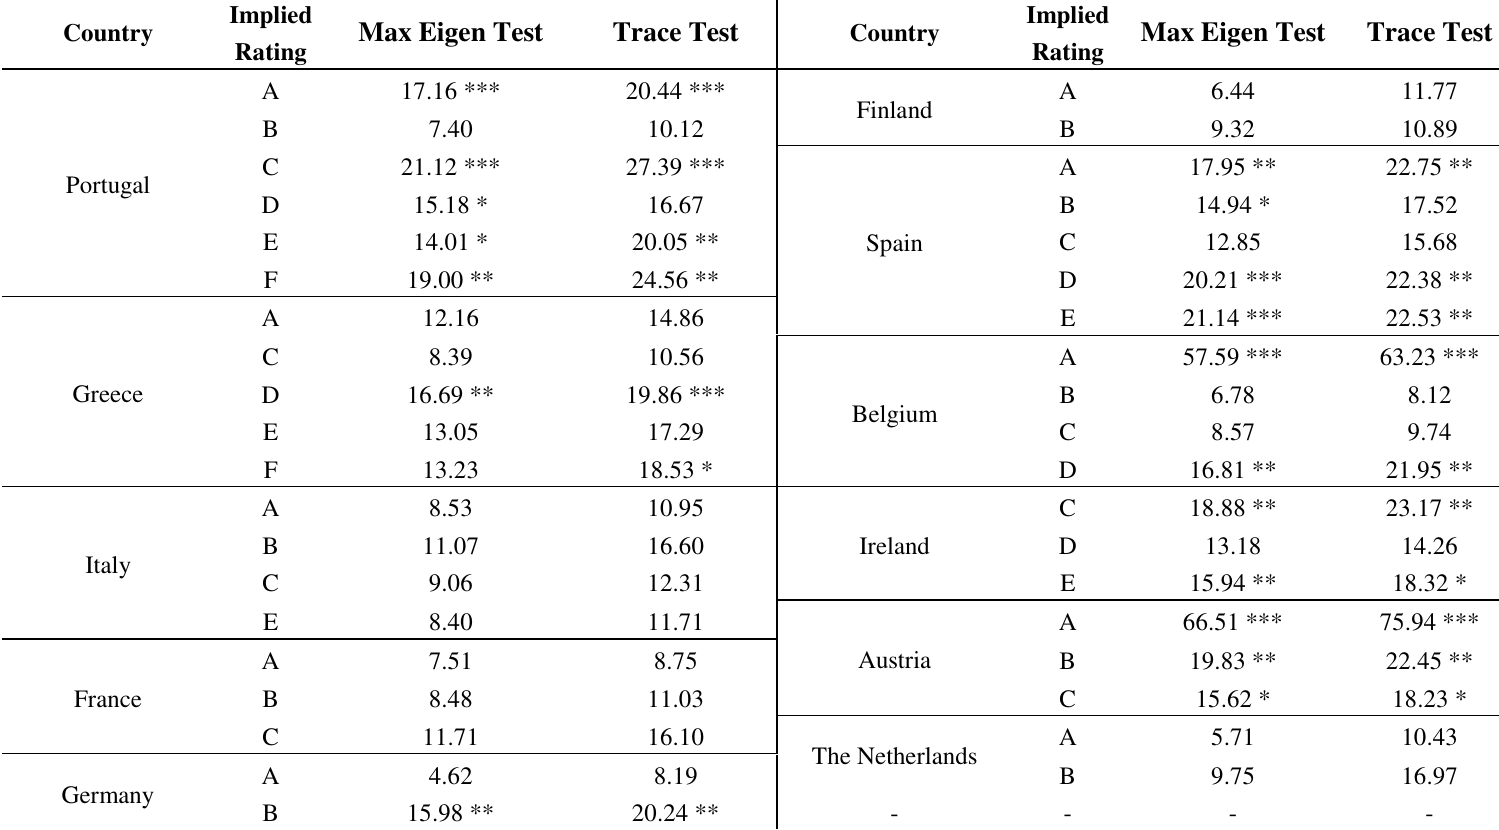
Table 5. Cointegration tests: log of stock index prices and CDS